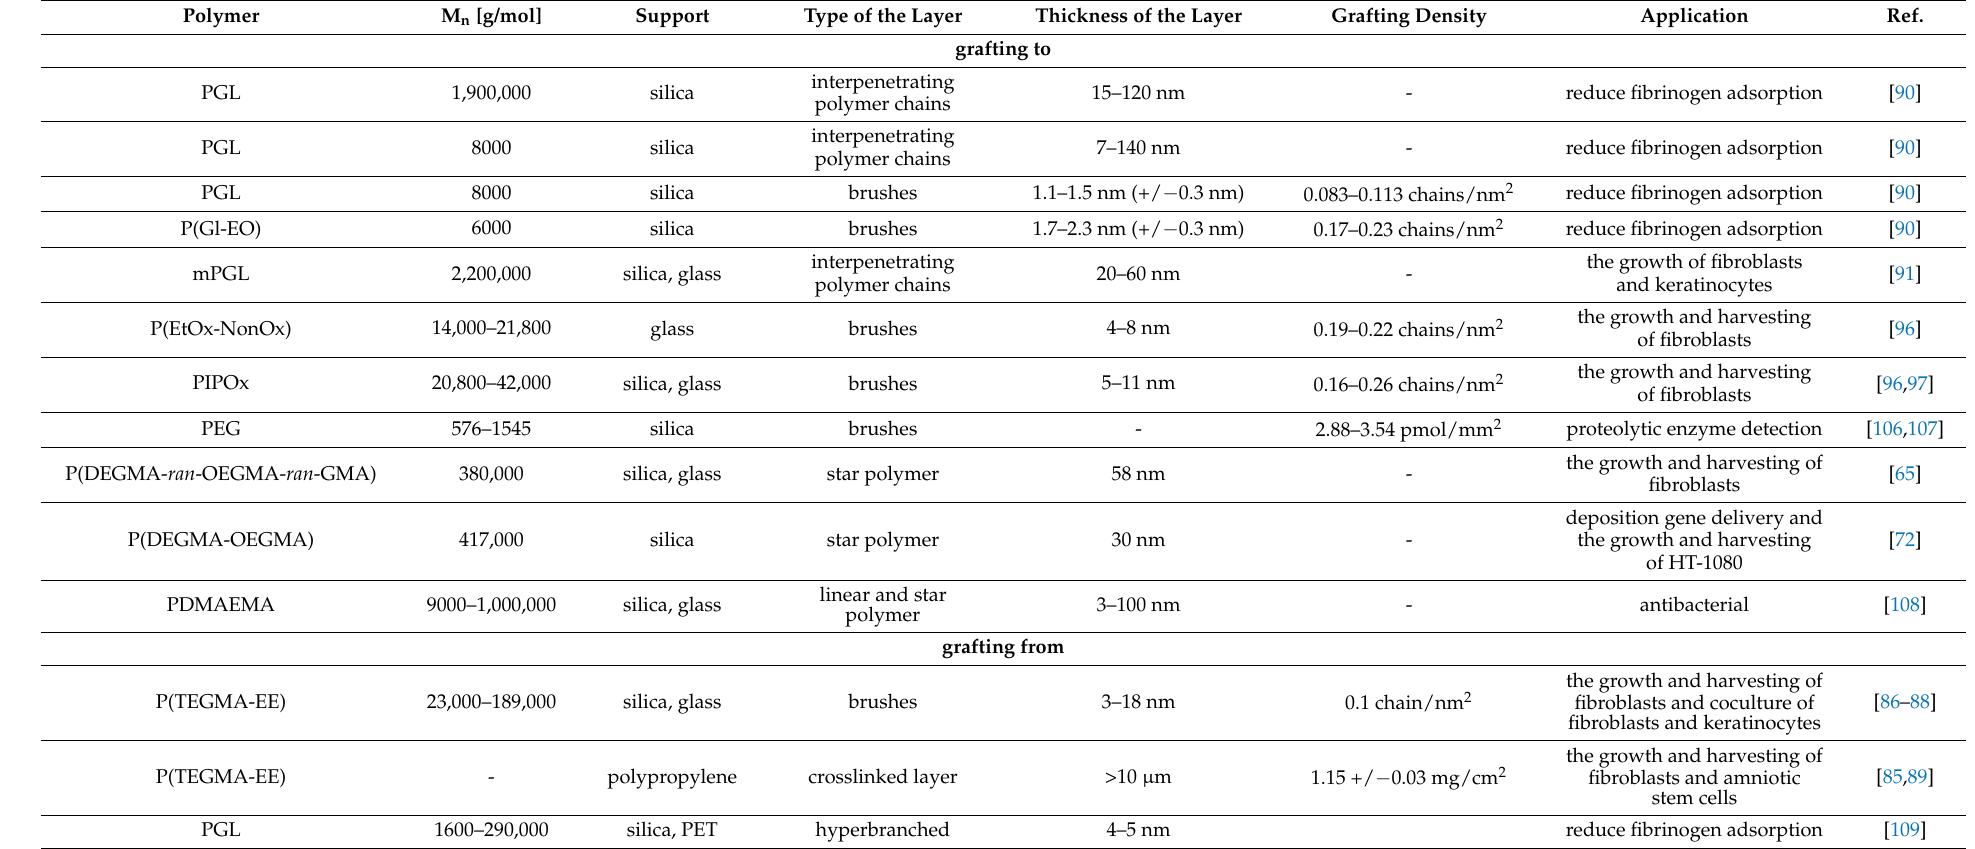
Table 3. Characteristics of the linear and branched polymer layers immobilized on a